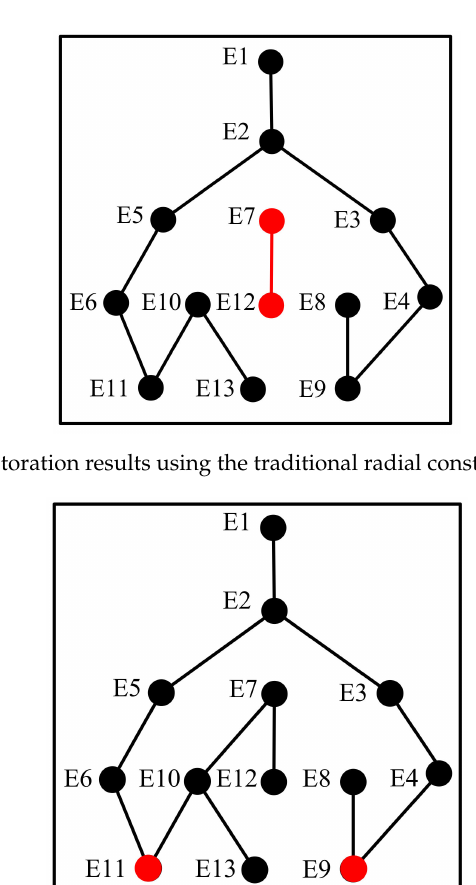
Figure 15. Topology of electric distribution network when a fault happens.